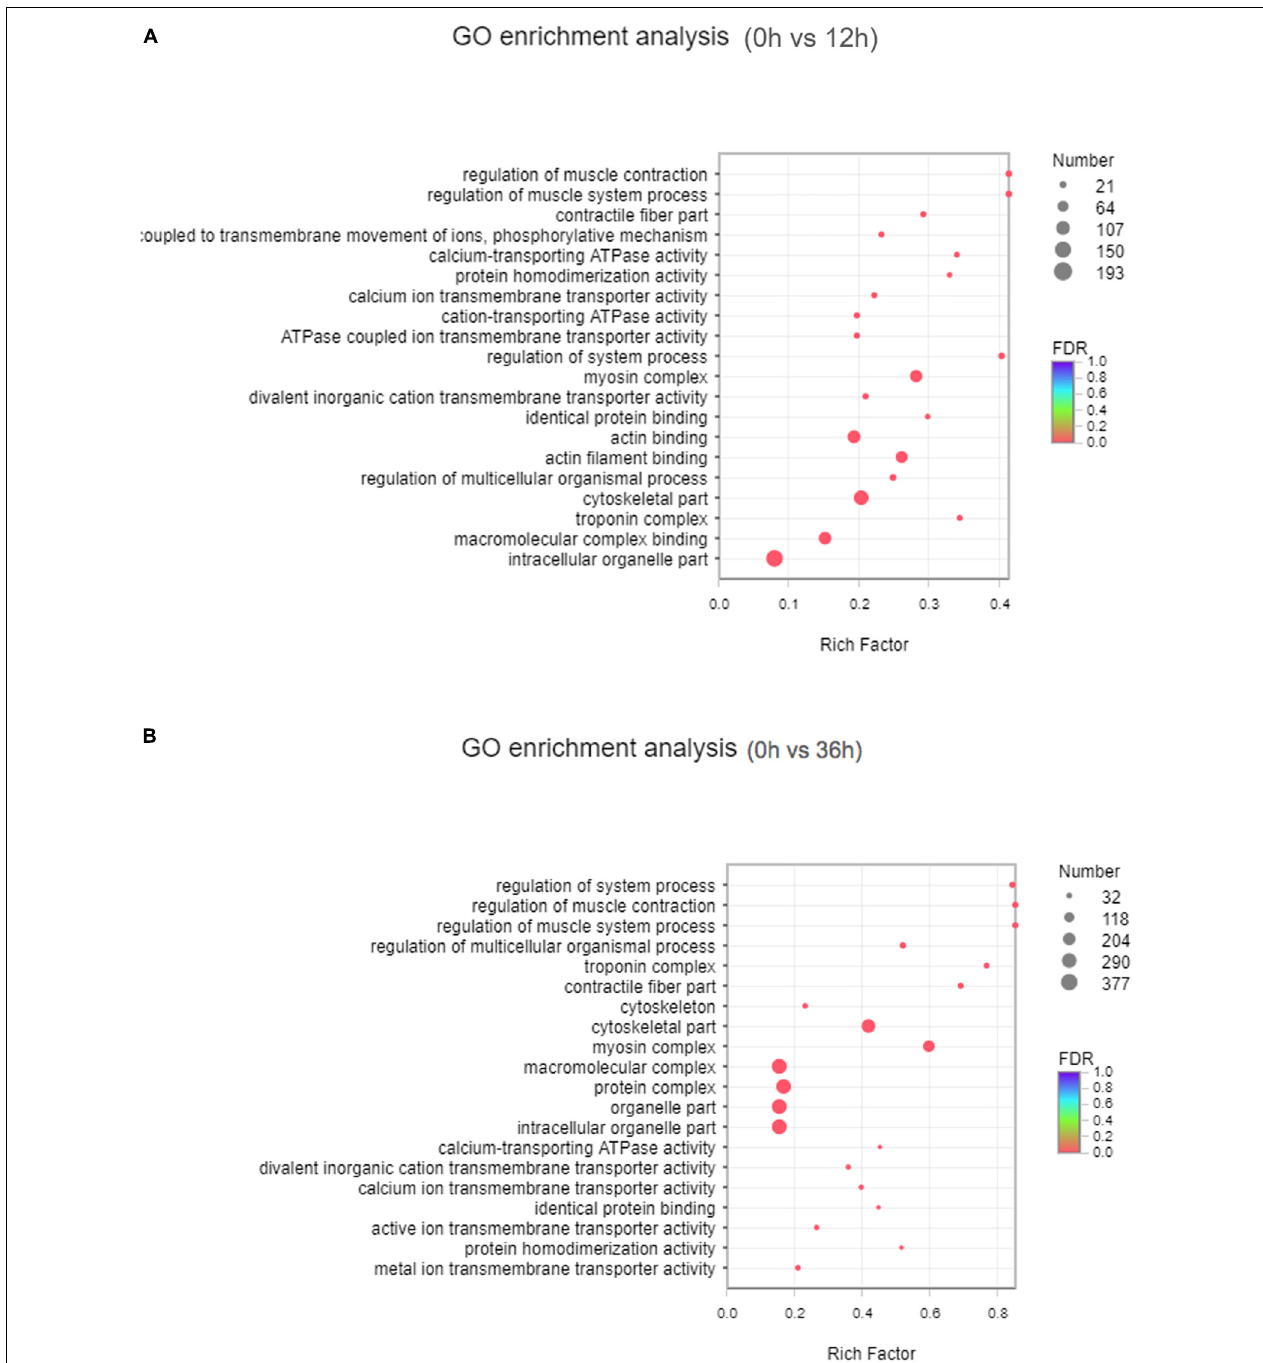
FIGURE 2 | GO was significantly enriched in the transcriptome. (A) Analysis of the GO in 0 vs. 12 h group. (B) Analysis of the GO in 0 vs. 36 h